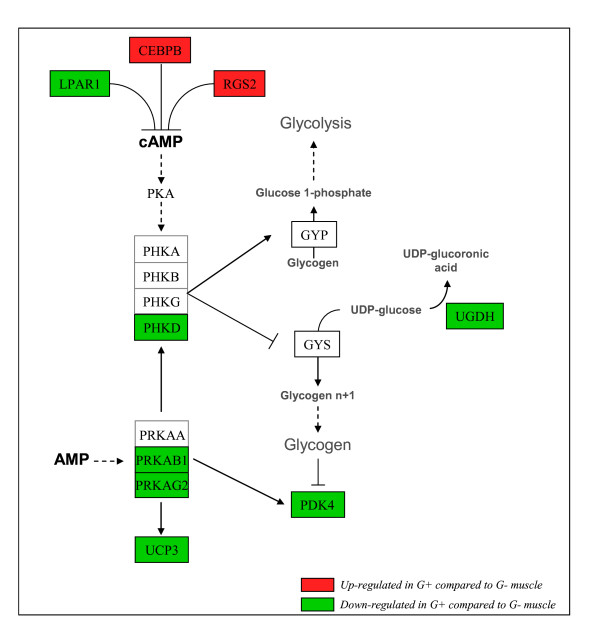
Summary of changes observed in the expression of genes involved in the regulation of glycogen storage in G+ and G- chickens and putative interactions between them. Genes highlighted in red and green were up- and down-regulated in G+ compared to G- muscle, respectively. Genes in white boxes were not differentially expressed between G+ and G- muscles. Gene names are indicated in capitals: PHKA, PHKB, PHKG, PHKD, Phosphorylase kinase, alpha, beta, gamma, delta subunit, respectively; PRKAA, PRKAB, PRKAG, AMP-activated protein kinase, alpha, beta, gamma subunit, respectively; PKA, Protein kinase A; GYS, Glycogen synthase; PYG, Glycogen phosphorylase. See Table 3 for other gene names.